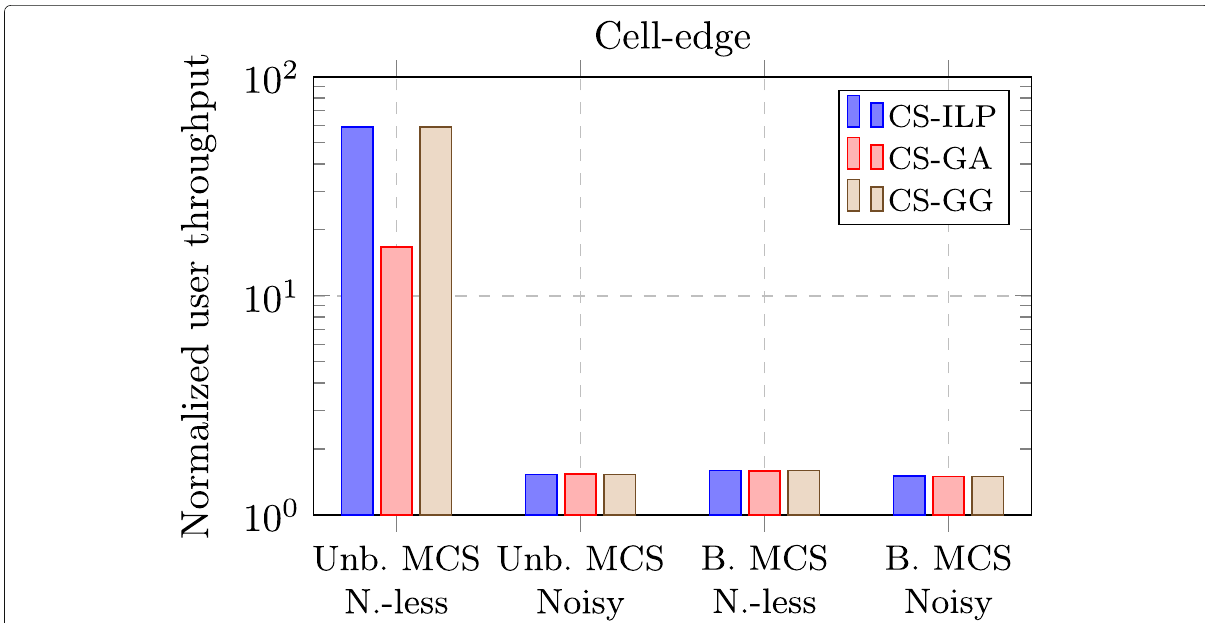
Fig. 2 Average cell-edge user throughput for the CoMP CS schemes, normalized with respect to the non-coop. PFS. Scenario with M = 3 BSs, N = 30 UEs, L = 10 PRBs, and M (cid:4) = 2 BSs. Four cases with limitations on the maximum achievable data rate and the noise power level are considered. There is no out-of-cluster